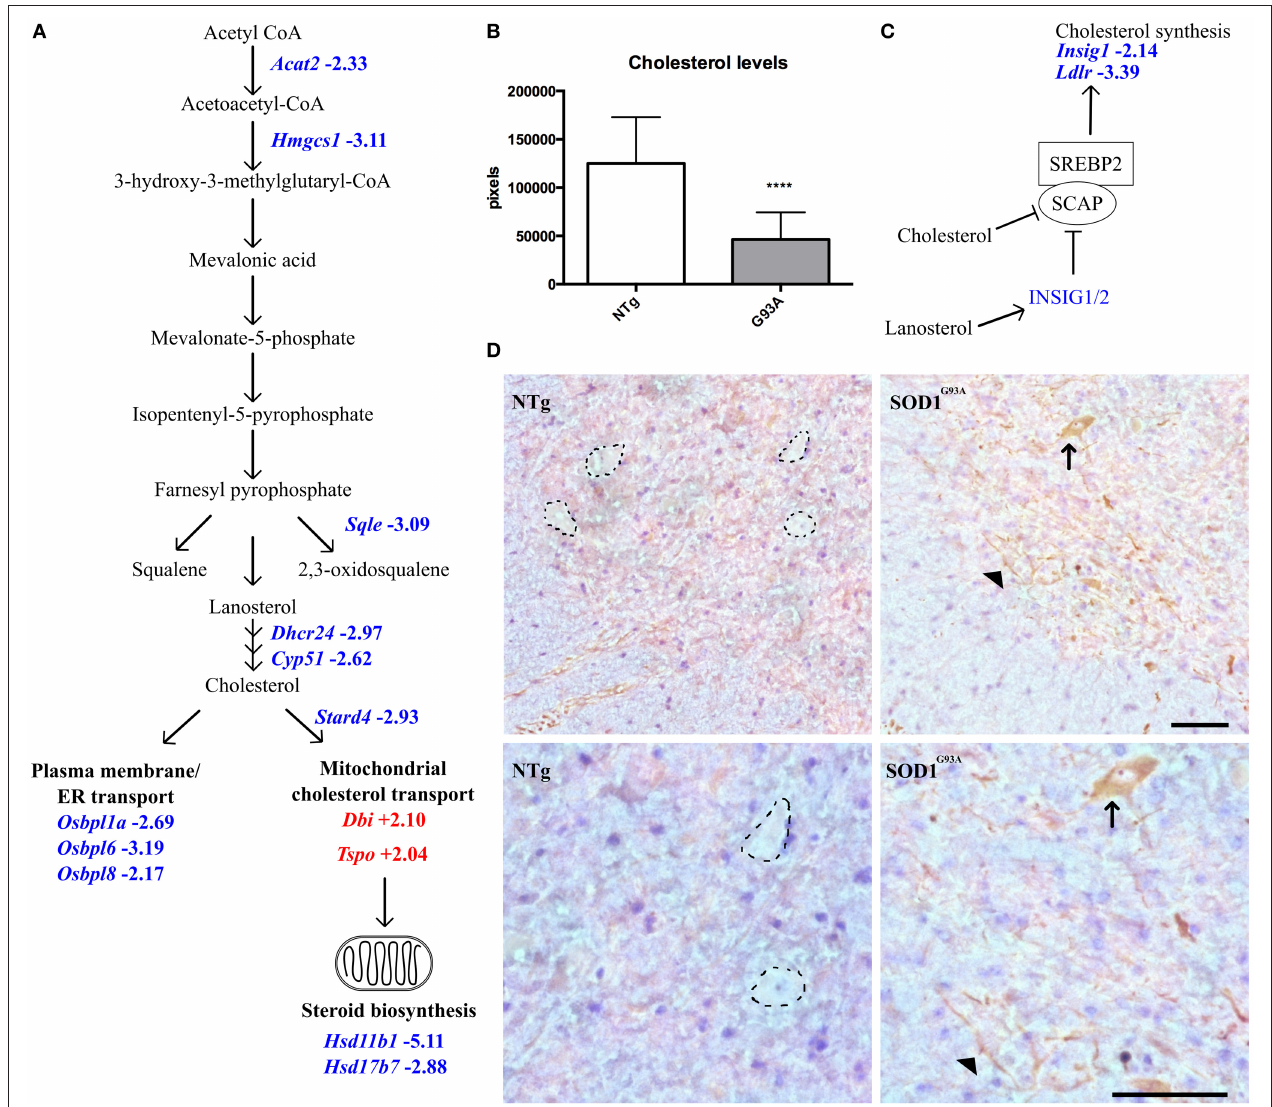
FIGURE 3 | (A) Transcripts involved in intracellular cholesterol synthesis and transport are dysregulated in late-stage SOD1 G93A astrocytes vs. NTg controls. Blue indicates decreased expression, red indicates increased expression, number indicates fold-change vs. NTg control. (B) Intracellular cholesterol levels in neonatal SOD1 G93A astrocytes are significantly lower than those in NTg controls. (C) Simplified schematic of SREBP2 regulation. Excess cholesterol or lanosterol inhibits SCAP-mediated transport of SREBP2 to the golgi apparatus. Consequently, SREBP2 is not activated and does not translocate to the nucleus to upregulate cholesterol synthesis and genes such as Insig1 and Ldlr which are decreased in late-stage SOD1 G93A astrocytes. (D) SREBP2 staining in the ventral horn of NTg (left) and SOD1 G93A (right) lumbar spinal cord of late-stage mice, top panels indicate 20X magnification and bottom panels 40X magnification. In NTg spinal cord, negatively stained areas show the morphology of motor neurons (dotted lines) whereas in SOD1 G93A spinal cord cells with motor neuron morphology stain positively for SREBP2 in the cytoplasm (arrow). In addition SREBP2 appears to be located in long processes which may belong to astrocytes or neurons (arrowhead). Scale bars = 100 µ m. **** p ≤ 0.0001